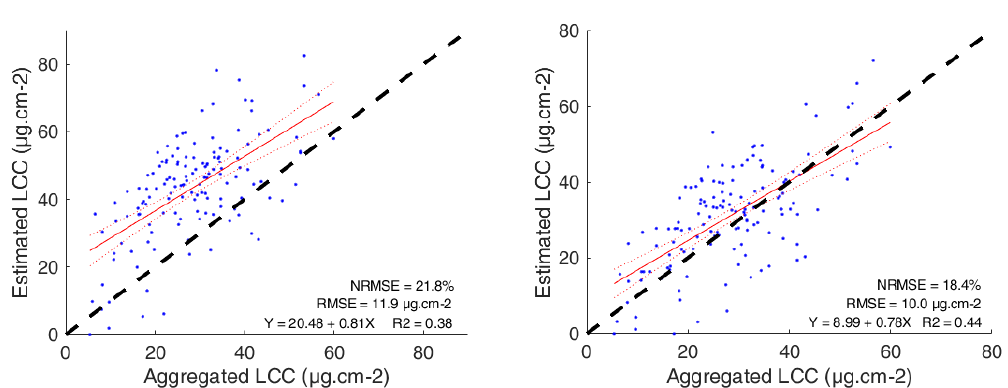
Figure 7. Comparison of the performances of two retrieval models estimating LCC. On the left, the OLCI model developed in [19] (LCC) and, on the right, the newly developed OLCI model integrating pixel heterogeneity (LCC*).